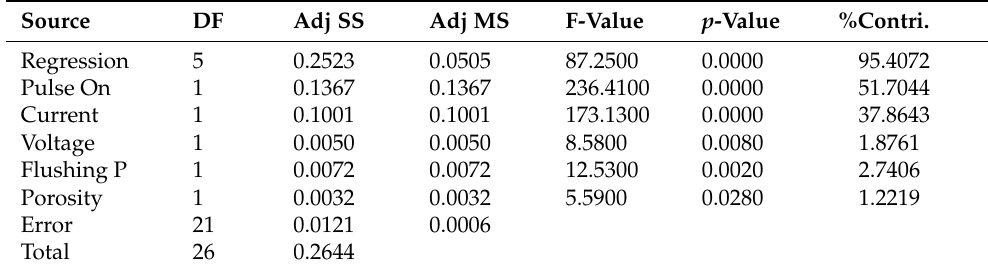
Table 7. Analysis of variance analysis for TWR.